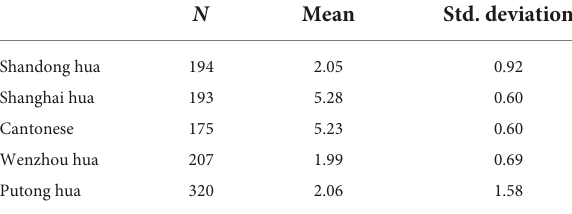
TABLE 5 Educational motivation by most exposed dialect.